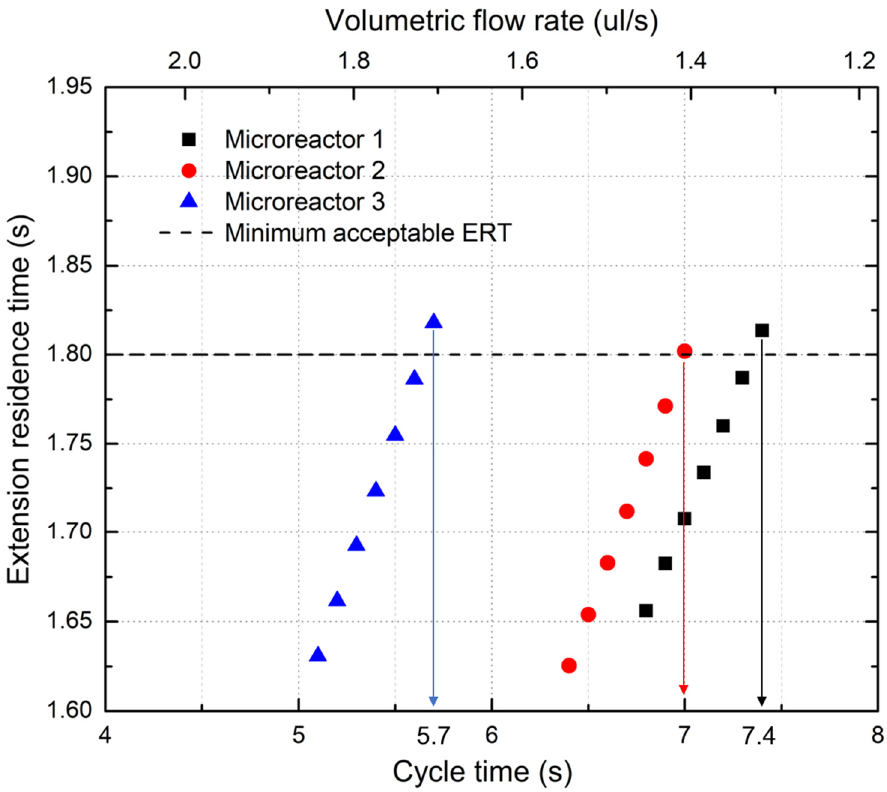
Figure 4. Extension residence time vs. cycle time (or volumetric flow rate) for all three microreac- tors.